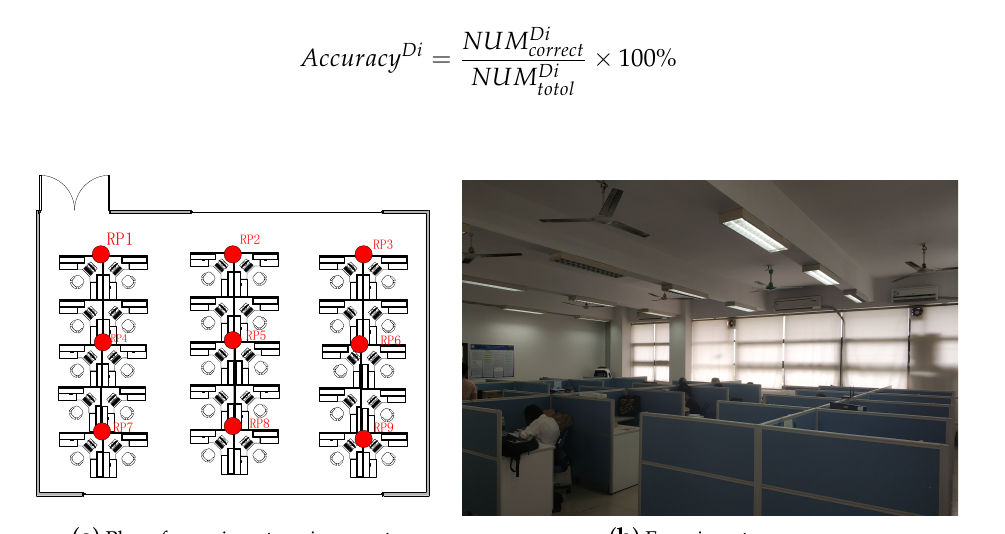
Figure 6. Experiment environment